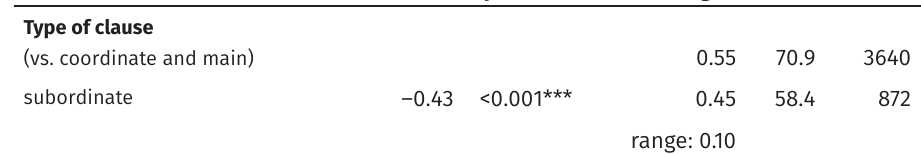
Table 14: The significance of the use of null subject for TYPE OF CLAUSE recoded (coordinate and main clauses vs. subordinate clauses) (intercept = 1.54; N = 4512; [Ø] =